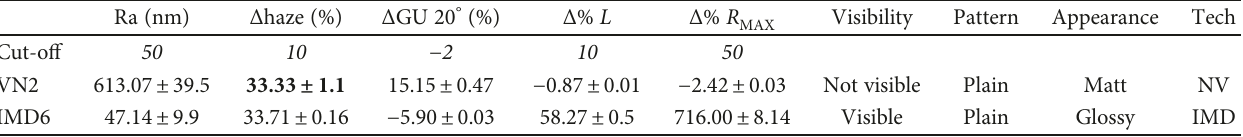
Table 6: Average results of signi fi cant parameters for the selected surfaces and relative classi fi